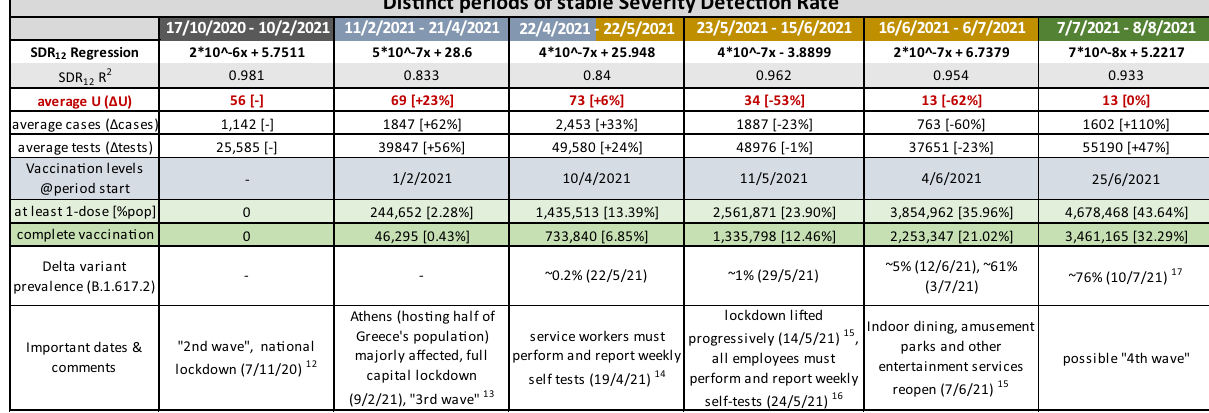
Table 2. Regression equations per distinct period of stable Severity Detection Rate, with respective average numbers of observed daily needs for new ICU admissions, cases detected and tests performed, vaccination coverage at the beginning of each period, percent of Delta variant prevalence in cases detected, along with important dates and comments that potentially influenced the course of the pandemic in Greece (each period is color-coded with reference to the respective ‘distinct periods of testing levels’, in Table